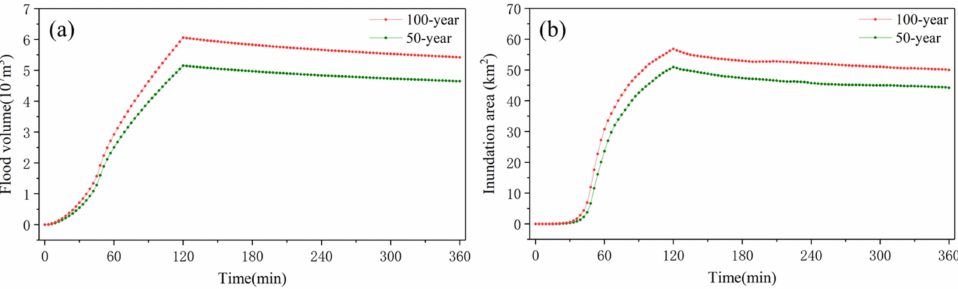
Figure 8. The statistical results over time for different return periods.